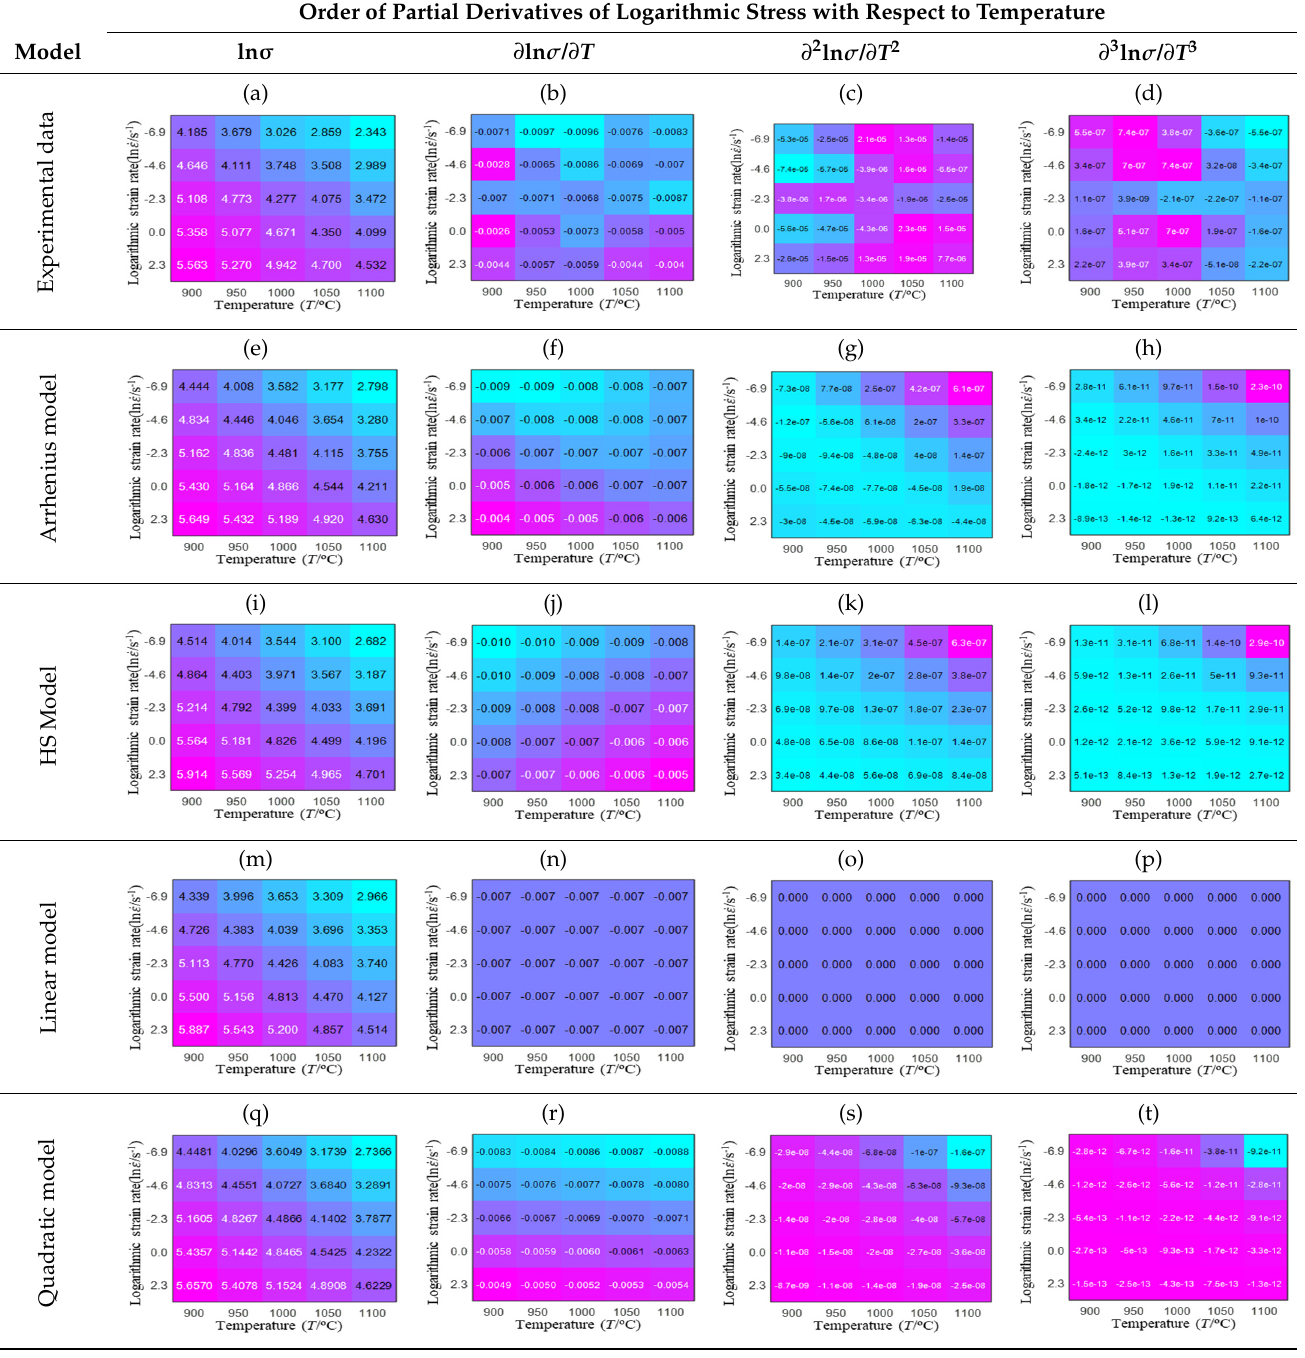
The fi rst, second and third partial derivatives of logarithmic stress with respect to logarithmic strain rate for experimental data and di ff erent models are listed in Table 9, when strain is equal to 0.04, by using Equations (22) and (23). The redder the color in the fi gure, the smaller the value represented. It can be seen from Table 9 that the second-order partial derivatives of logarithmic stress with respect to logarithmic strain rate for the Ar- rhenius model, the HS model and the linear model are close to zero. It is worth noting that the third partial di ff erential of logarithmic stress with respect to logarithmic strain rate for the quadratic model is close to zero. This phenomenon is determined by the equation of